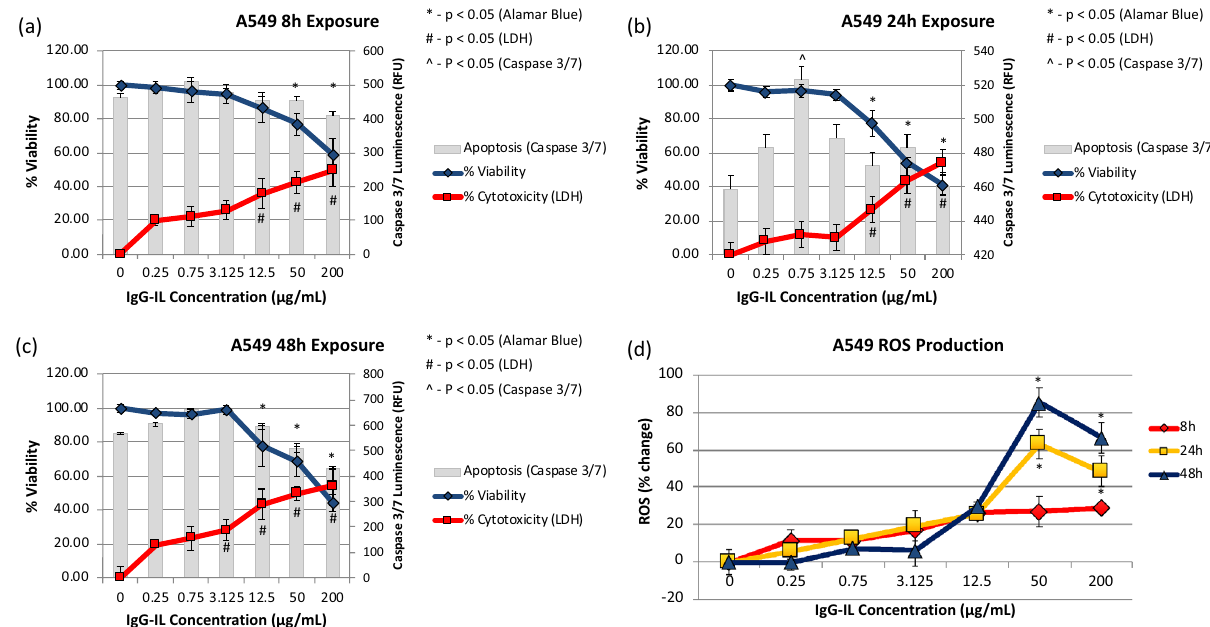
Figure 3. The viability (blue line, left y-axis), cytotoxicity (red line, left y-axis), and apoptosis (grey columns, right y-axis) results for A549 cells exposed to IgG-IL for 8 ( a ), 24 ( b ), or 48 ( c ) hours. Reactive oxygen species generation at 8, 24, and 48 h ( d ). Statistical significance was determined by a One-way ANOVA and a post-hoc Tukey’s Test compared to no treatment, at a confidence of 95% for n = 3, r = 6.